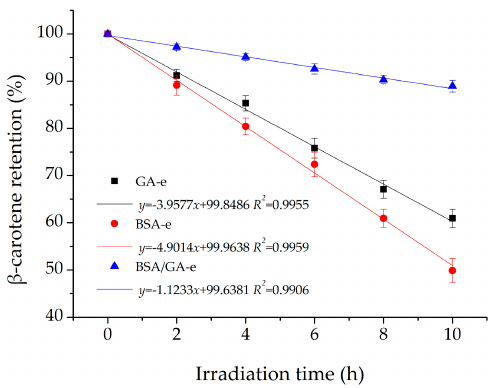
Figure 4. The effects of UV irradiation on the β -carotene retention of the three emulsions studied. The β -carotene retention of the three emulsions studied were measured after the UV radiation for 0, 2, 4, 6, 8, 10 h. Each data point is an average of triplicate, and the standard deviations are given. Solid lines represent the fitting results from the linear equation using OriginPro.